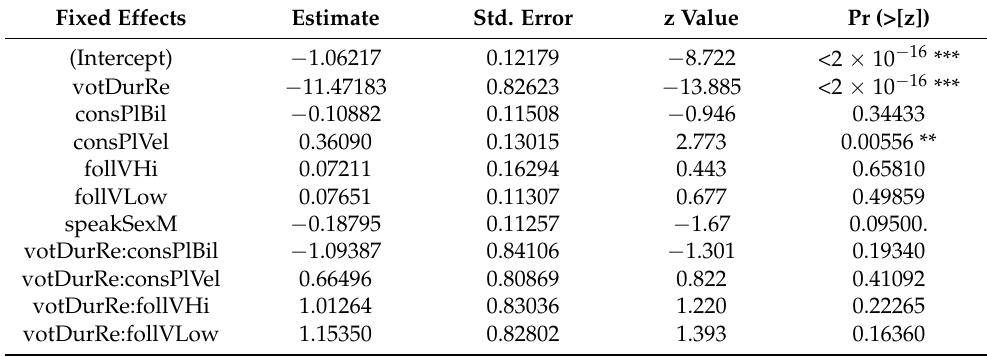
Table A3. Generalized linear mixed model (Experiment 2, original and resynthesized voice